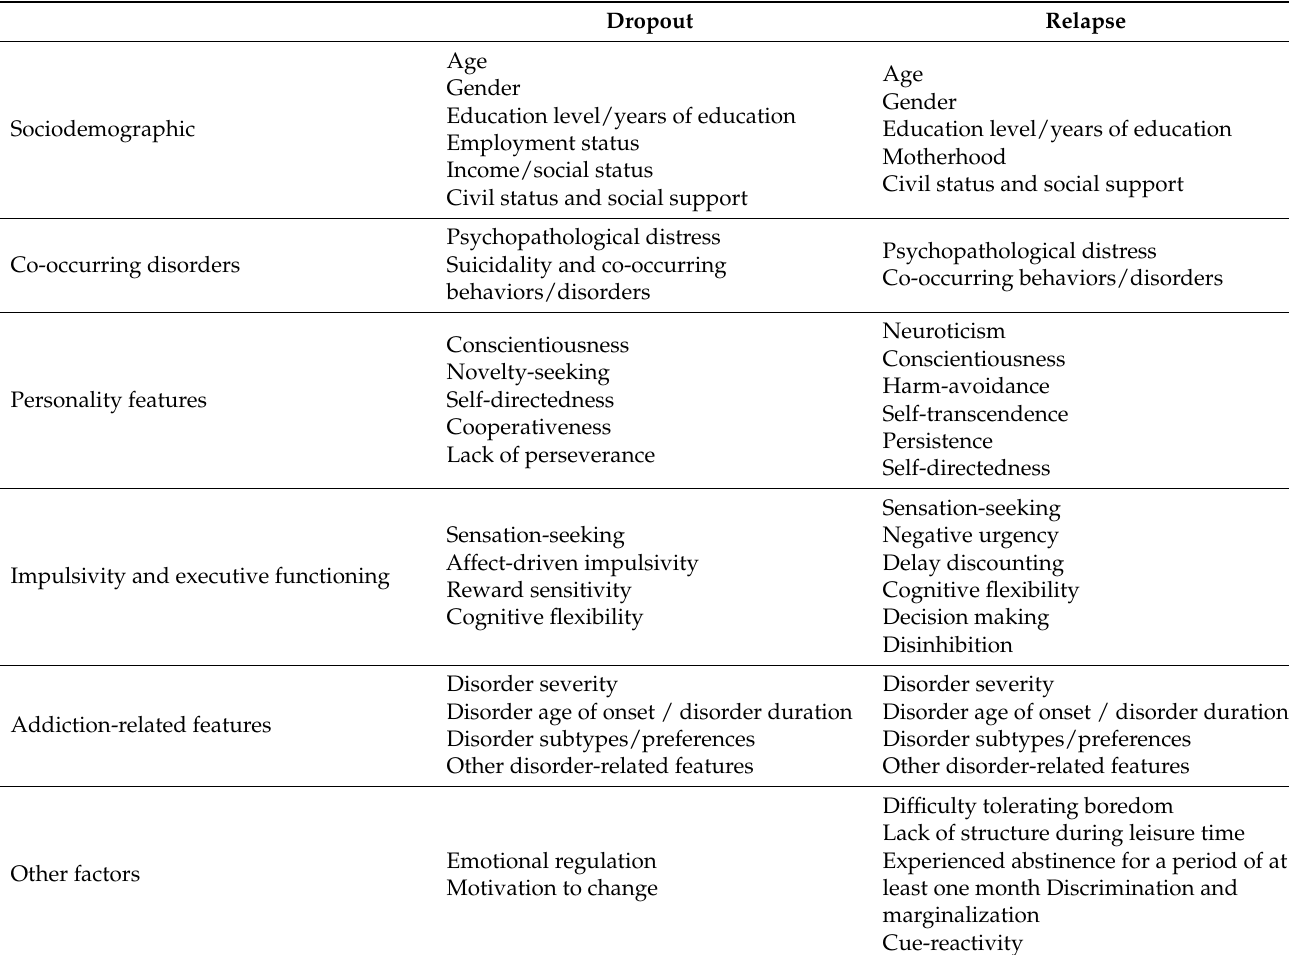
Table 1. Main features included in the present